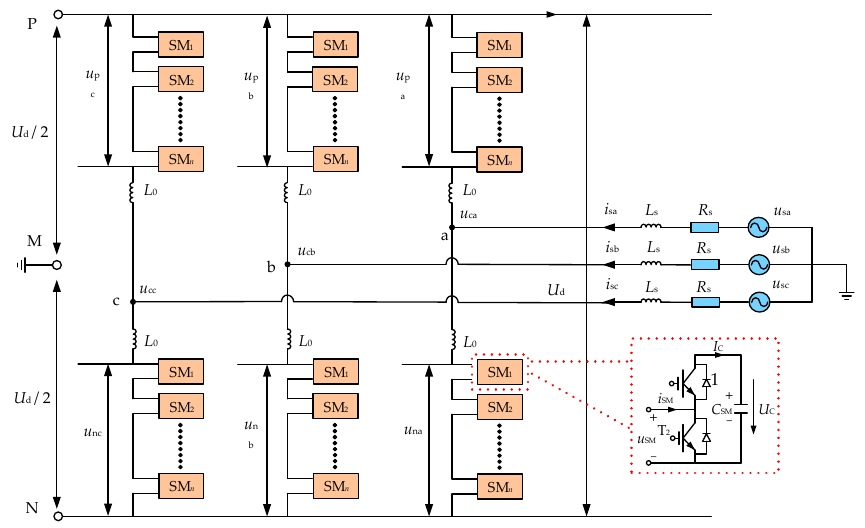
Figure 5. Schematic diagram of VSC.